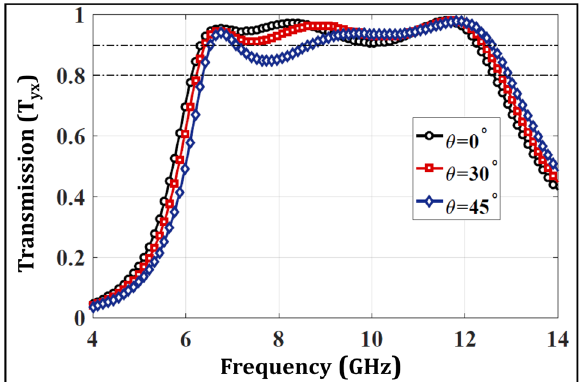
Figure 10. Transmission behavior with respect to different incident angles for proposed structure.